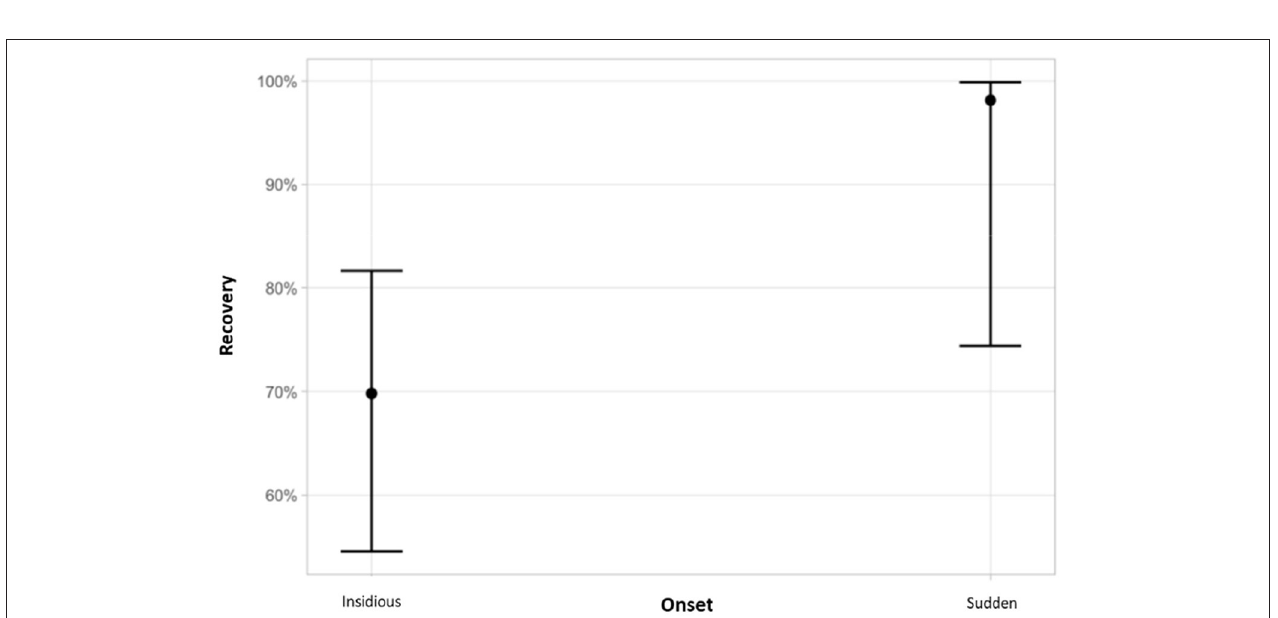
FIGURE 7 | Association between recovery and age at onset. Demonstration of the relationship between recovery and age at onset of clinical signs. The y-axis shows probabilities of recovery predicted by the logistic regression. Younger cats were more likely to recover ( p = 0.005).